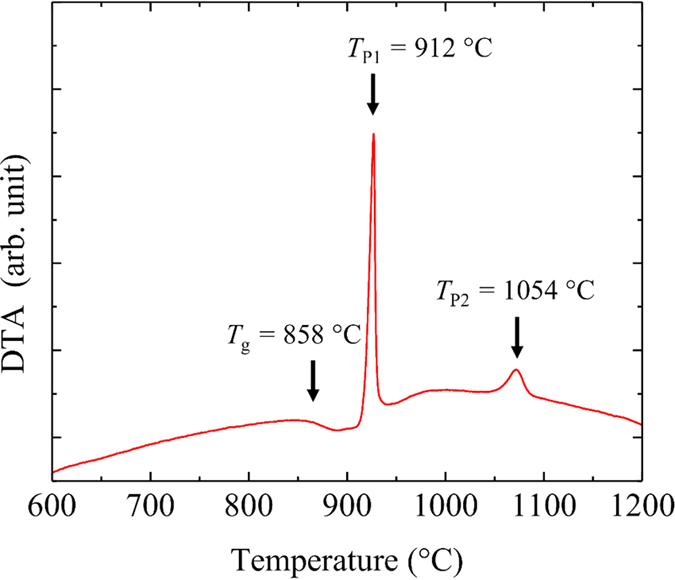
DTA curve for the 54Al2O3-46Ta2O5 glass showing Tg, and the first (TP1) and second crystallization peaks (TP2).